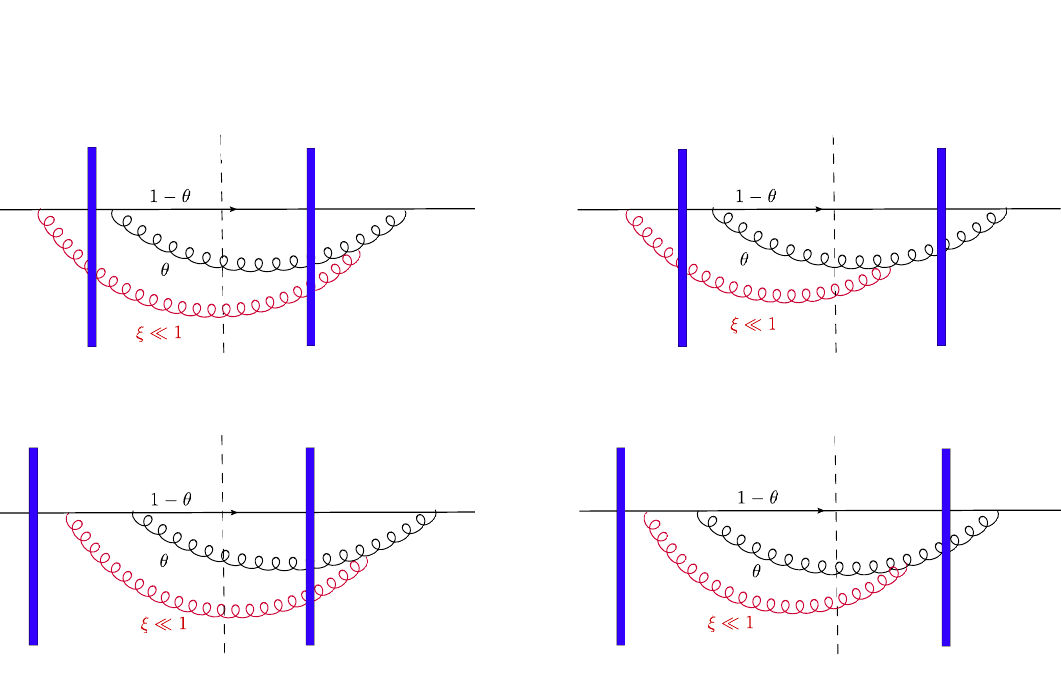
Figure 19 . The four diagrams contributing to the cross-section (3.52) in the eikonal limit ξ → 0 (the soft gluon is shown in